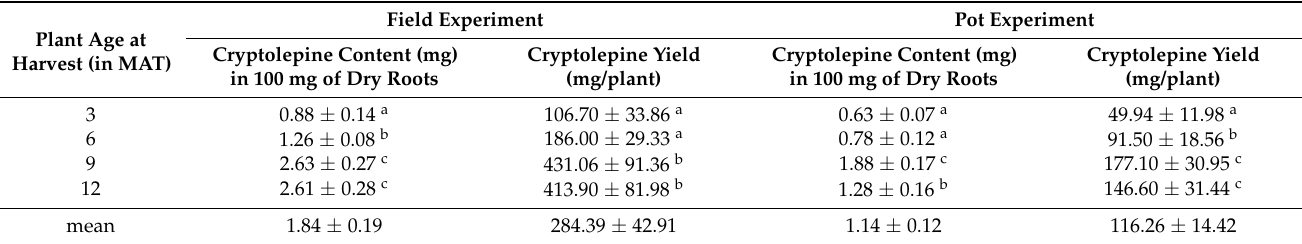
Table 3. Mean cryptolepine content and yield at different harvest periods.